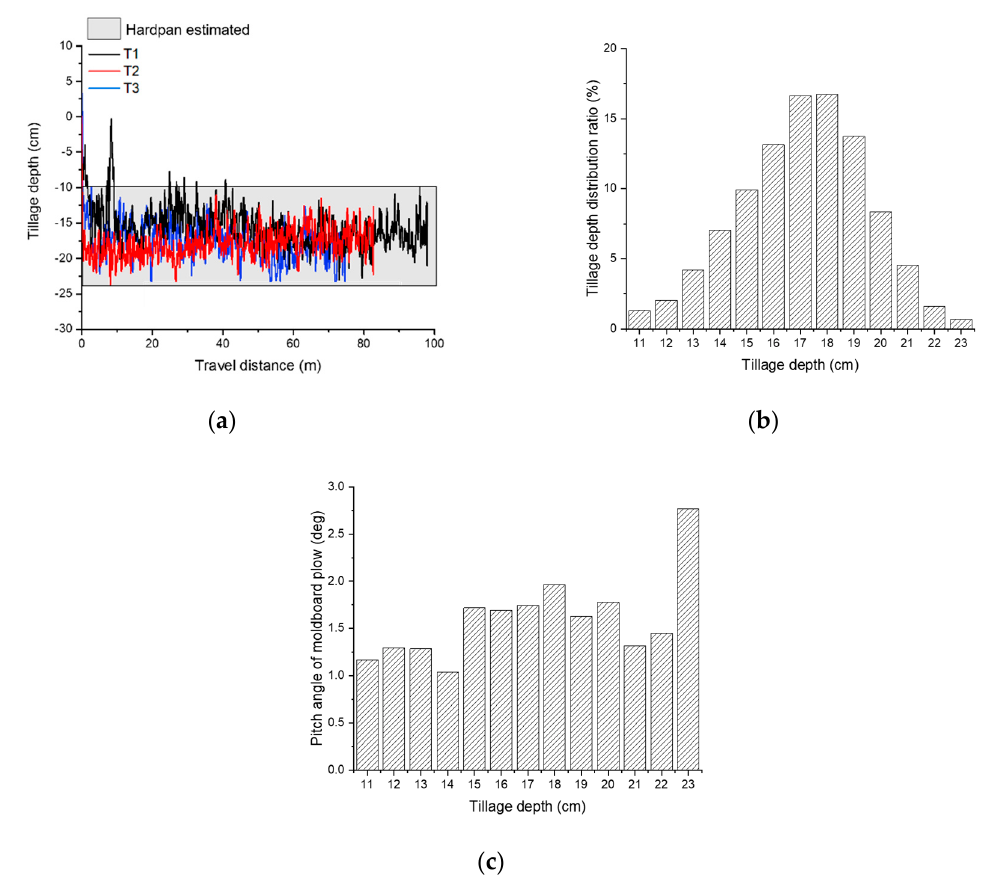
Table 4. Descriptive statistics of measured tillage depth (cm) during the field experiment.